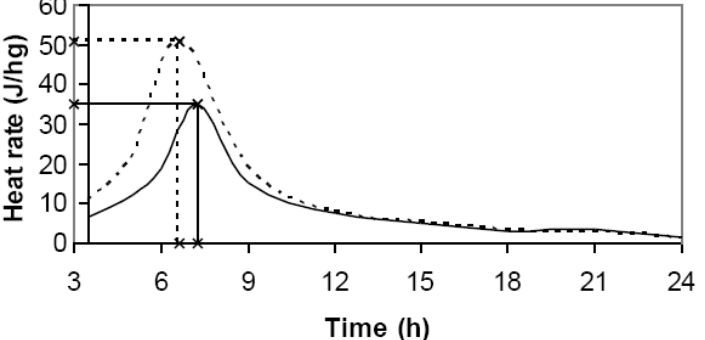
Figure 1. Heat rate versus time for wood-cement (solid curves) and neat-cement (dashed curves).